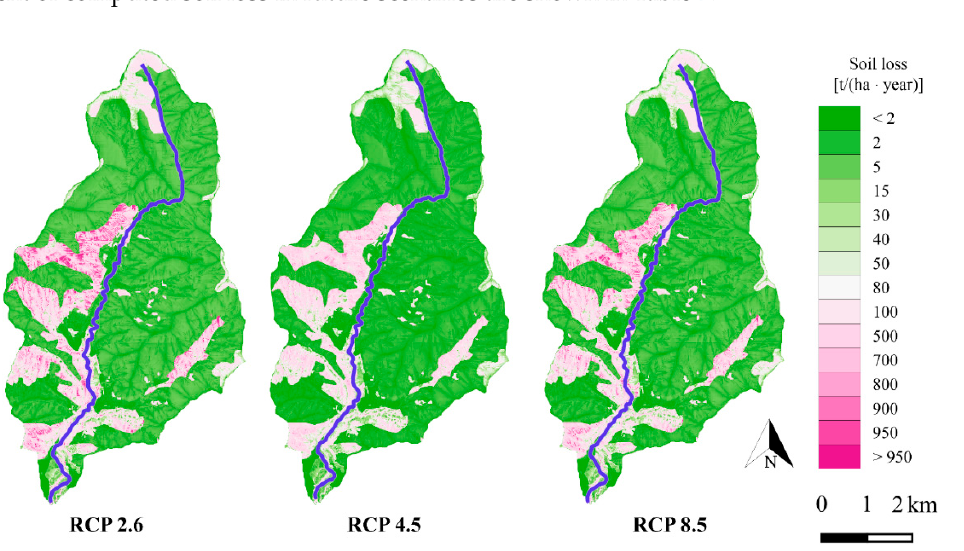
Table 7. Computed soil loss (Revised Universal Soil Loss Equation (RUSLE) method) considering different future scenarios.